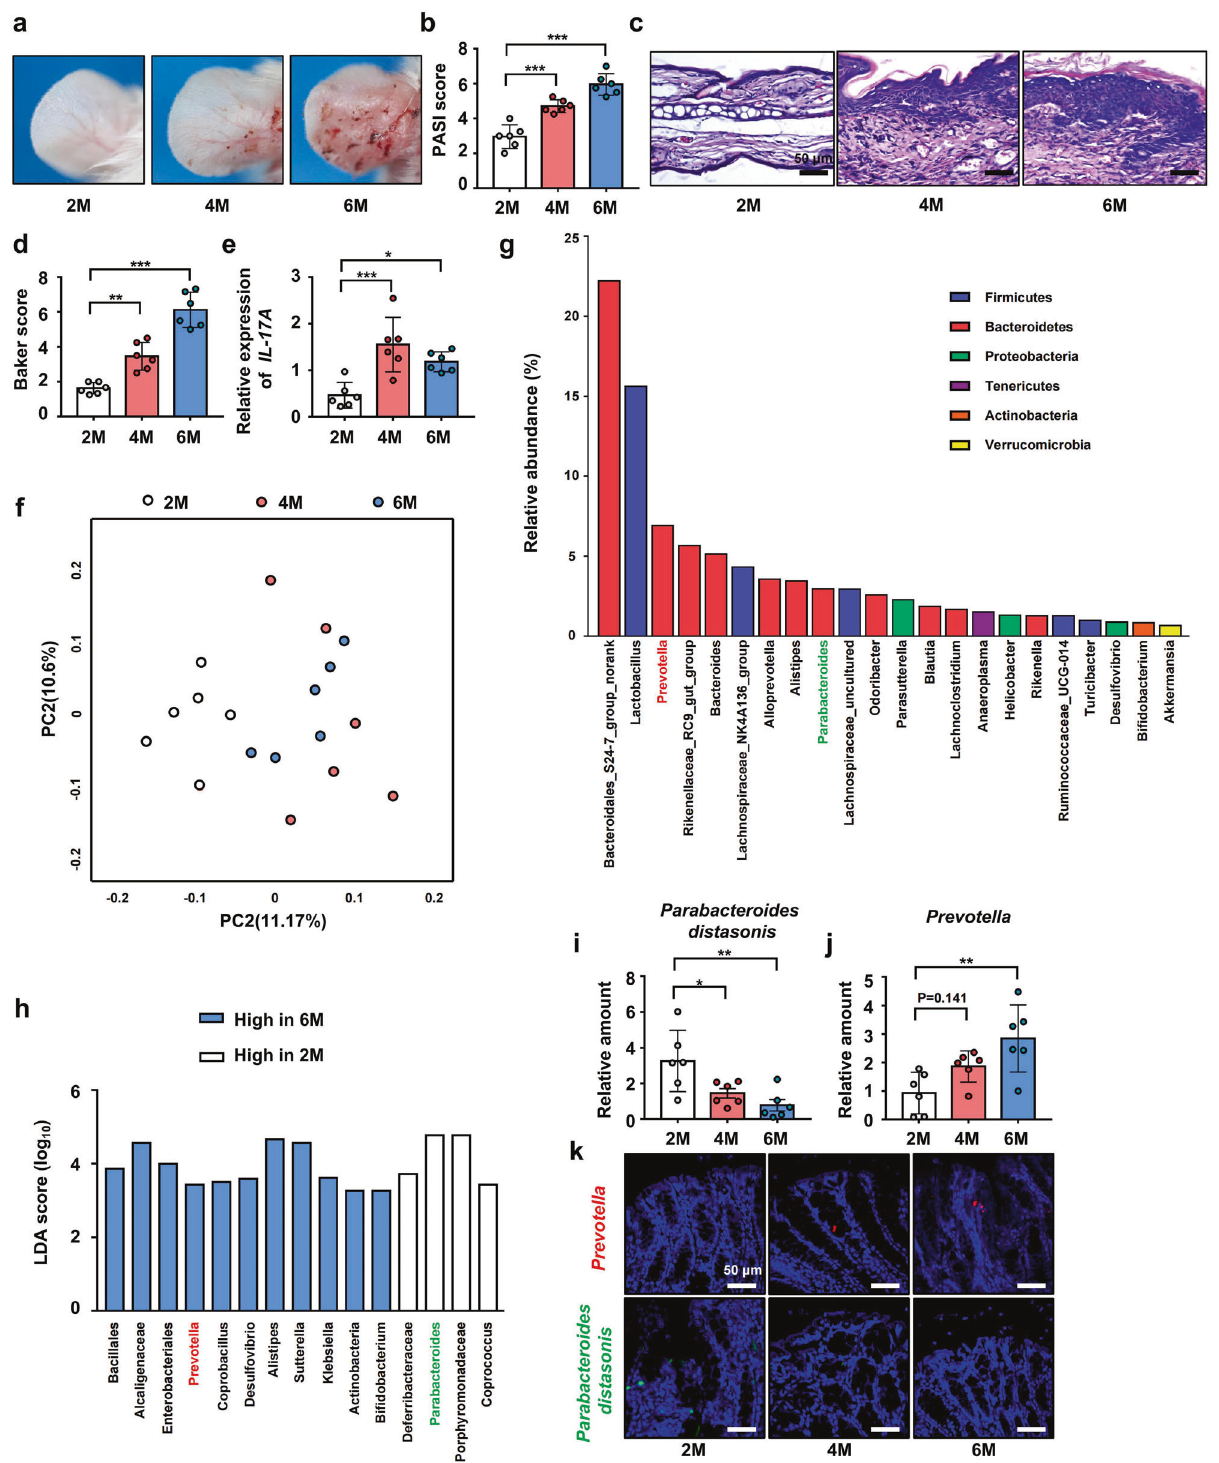
Fig. 1 Severity of psoriasis-like skin phenotype increases with age in K14-VEGF transgenic mice, and this is accompanied with changes in the composition of the intestinal microbiota. a Macroscopic characteristics of the ears in 2 M, 4 M, and 6 M mice. b PASI score of ears in 2 M, 4 M, and 6 M mice. c Representative H&E staining of ears of 2 M, 4 M, and 6 M mice. (Scale bars: 50 μ m). d Pathological score of ear sections using the Baker scoring system. e Relative mRNA expression of IL-17A in the ears of 2 M, 4 M, and 6 M mice. f Principal coordinates analysis (PcoA) of unweighted UniFrac distance based on 16s rDNA pro fi ling of feces from 2 M, 4 M, and 6 M mice. g Relative abundance of dominant species in the feces from 2 M, 4 M, and 6 M mice. h Results of linear discriminant analysis effect size (LEfSe) analysis showing bacteria, at the lowest taxonomic level, that were signi fi cantly different in abundance in 2 M and 6 M mice. i , j Fecal contents of 2 M, 4 M, and 6 M mice were analyzed for Prevotella and Parabacteroides distasonis colonization by qPCR. k Representative fl uorescence in situ hybridization for Prevotella (Prv392) and Parabacteroides distasonis (PD) in the colon. Data presented as mean ± SD on relevant graphs. * P ≤ 0.05; ** P ≤ 0.01; *** P ≤ 0.005 (one-way ANOVA). 2 M ( n = 6), 4 M ( n = 6), and 6 M ( n = 6). LDA linear discriminant analysis Signal Transduction and Targeted Therapy (2023)